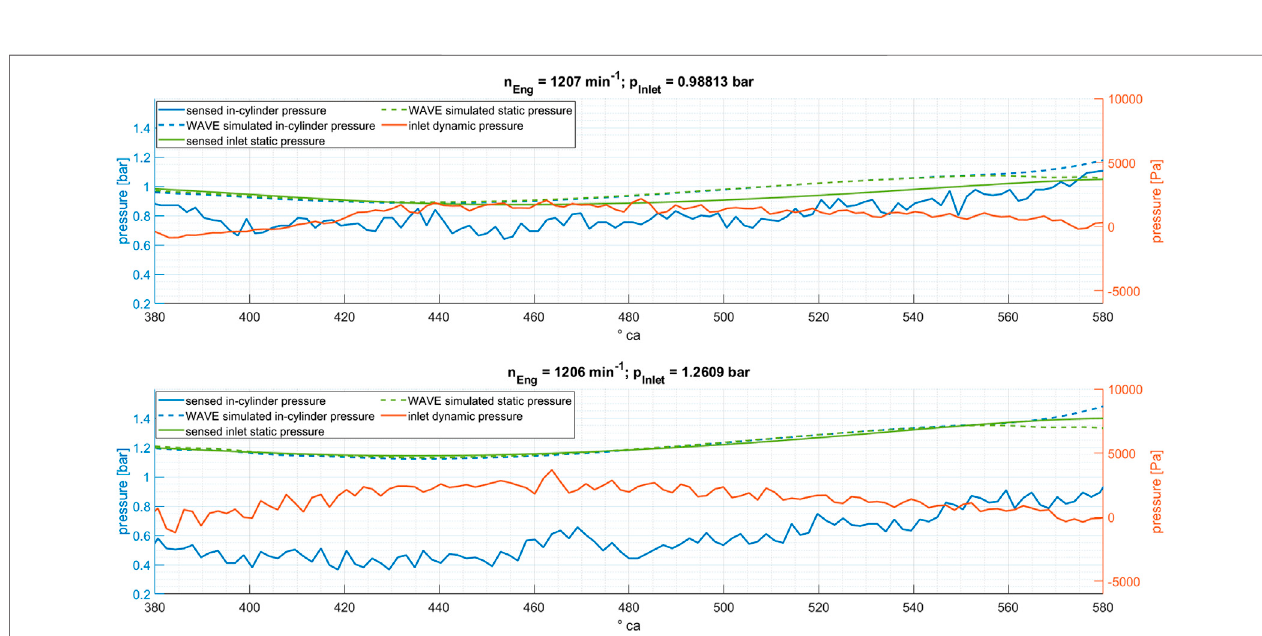
Frontiers in Mechanical Engineering |